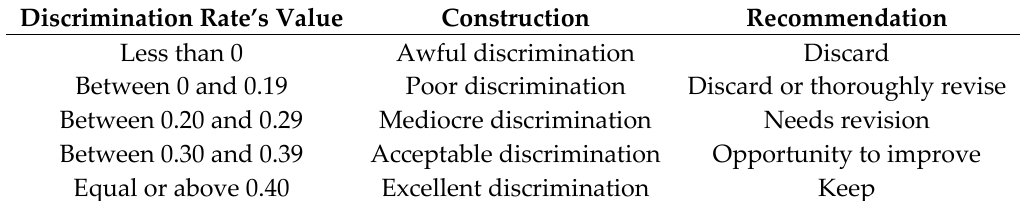
Table 1. Criteria for the discrimination rate’s values